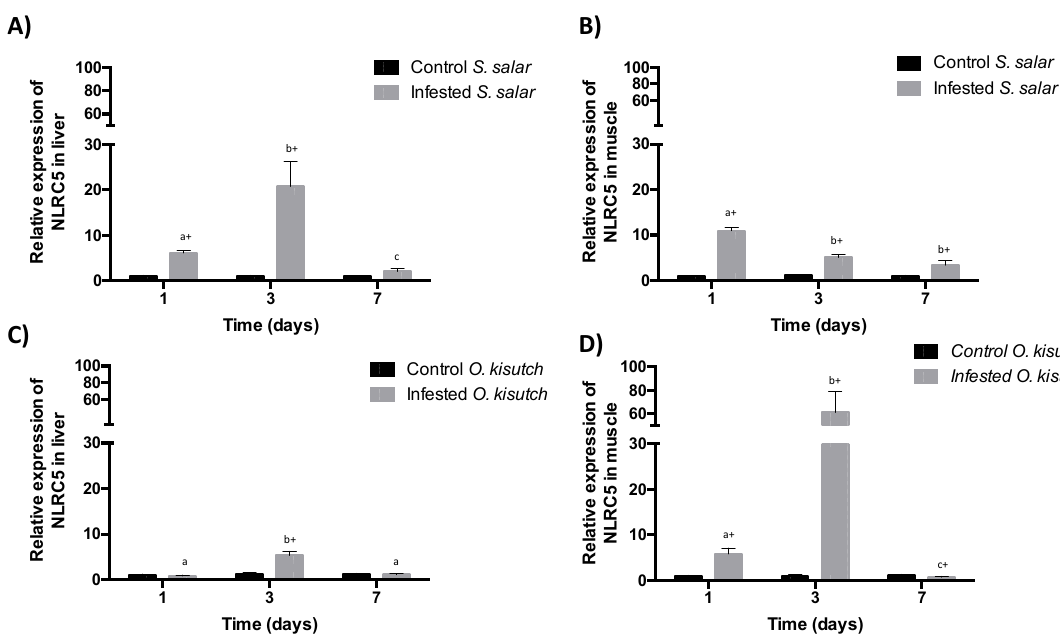
Figure 1. Relative expression of NLRC5 transcripts in Salmo salar and O. kitsuch muscle and liver infested with C. rogercresseyi . Relative mRNA expression of NLRC5 in muscle at 1, 3, and 7 dpi ( B , D ) and relative mRNA expression of NLRC5 in the liver at 1, 3, and 7 dpi ( A , C ). The 18s gene was used as a reference gene to calibrate the cDNA template for all samples. Bars represent the mean values ( ± S.E.) of 20 samples. Letters (a,b,c) represent statistical di ff erences within the same group over time. The + symbol represents statistical di ff erences at the same time-point between groups (i.e., infested vs. control). Statistical di ff erences were established by two-way ANOVA ( P < 0.05).